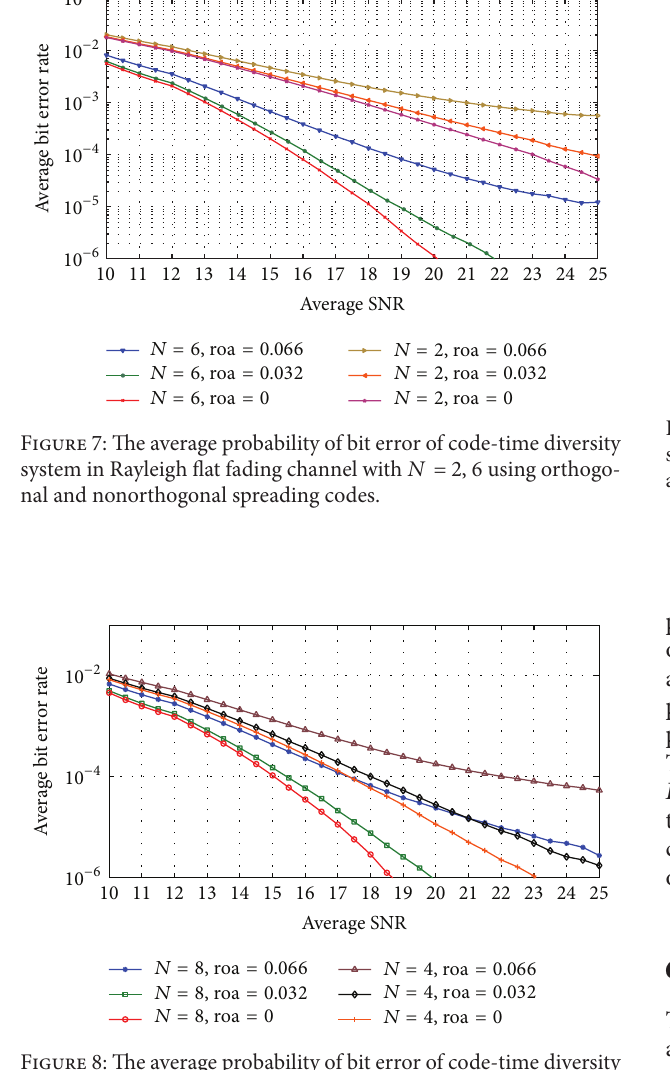
Figure 8: The average probability of bit error of code-time diversity system in Rayleigh flat fading channel with 𝑁 = 4, 8 using orthogo- nal and nonorthogonal spreading codes.